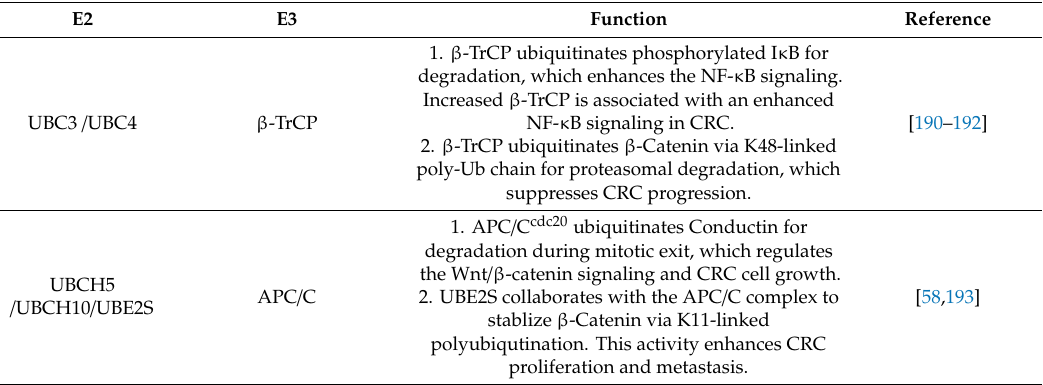
Table 1. Ubiquitination factors involved in regulating